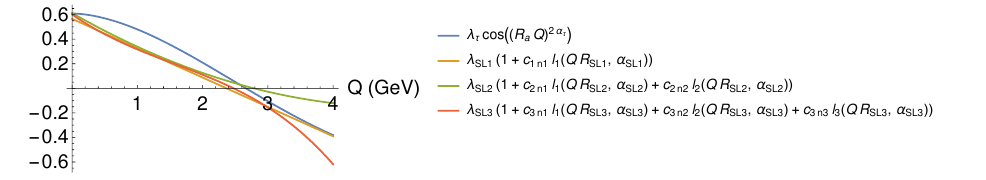
Figure 3. Comparison of the cosine term of the τ -model parametrization with the Lévy polynomial term of the symmetric Lévy parametrization.